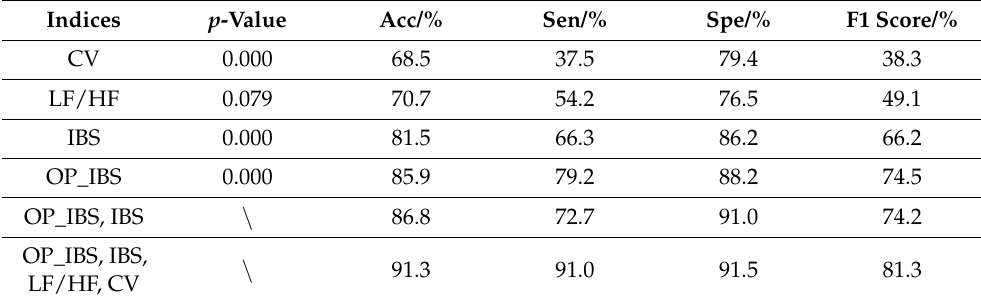
Table 4. Comparison between screening results of non-OSA-s and OSA-s